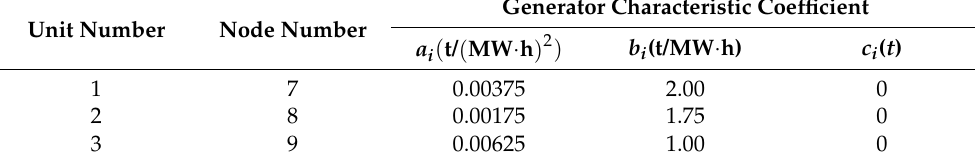
Table 4. Partial unit parameters.